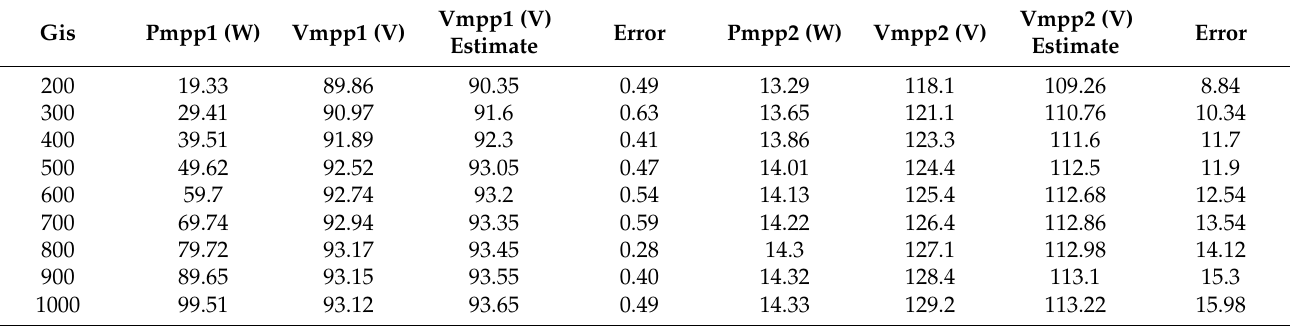
Table 3. The P-V characteristic data for test 1.